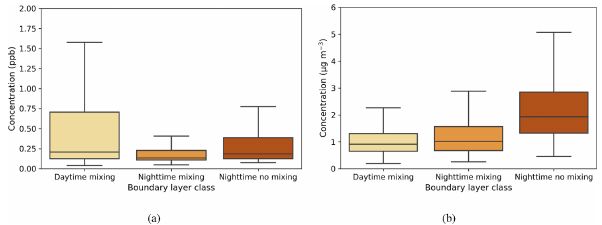
Figure A1. Box-and-whisker plots of hourly median values for three boundary layer conditions for (a) SO 2 (ppb) and (b) black carbon (µgm − 3 ). The central line in the boxes indicates the median, and the bottom and top lines of the boxes indicate the 25th and 75th percentiles. The whiskers mark the most extreme data points that are not considered to be outliers.